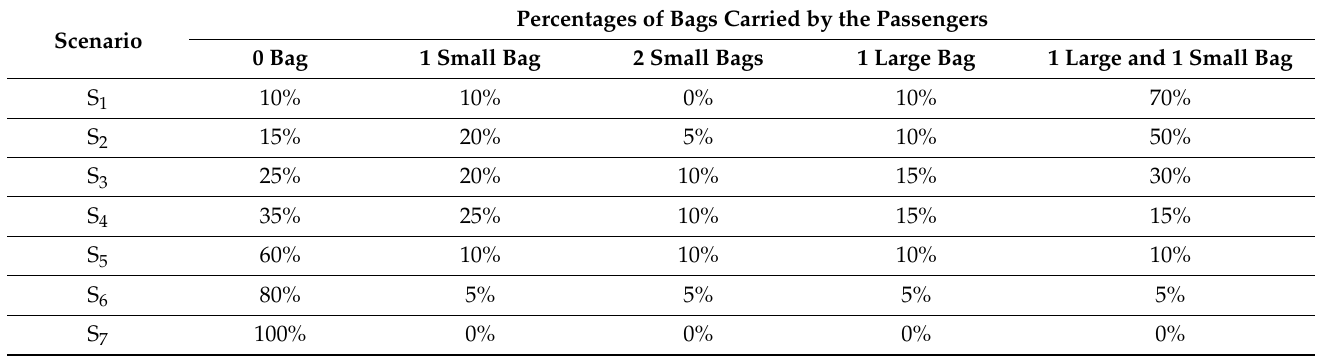
Table 2. The scenarios based on the quantity and type of hand luggage.